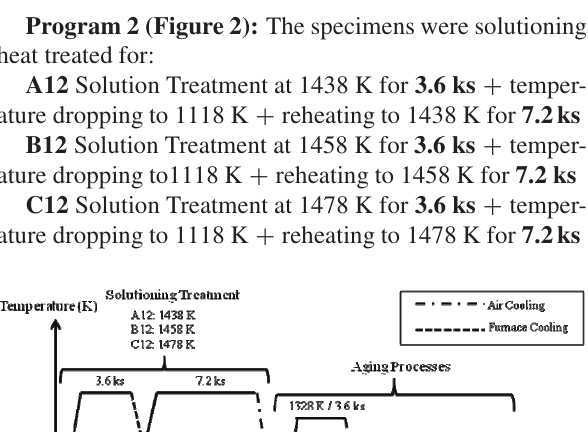
Figure 1. Simulated reheat treatment programs: A3, B3 and C3.